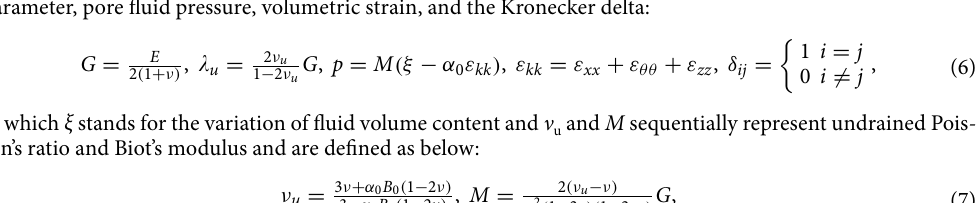
in which σ ij and ε ij sequentially stand for the stress and strain tensors and α 0 is the Biot coefficient of effective stress. Also, with the following definitions, G , λ u , p , ε kk , and δ ij represent the shear modulus, undrained Lame parameter, pore fluid pressure, volumetric strain, and the Kronecker delta: